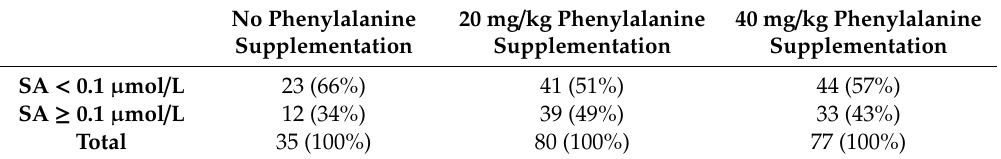
Table 4. Blood succinylacetone (SA) concentrations during the